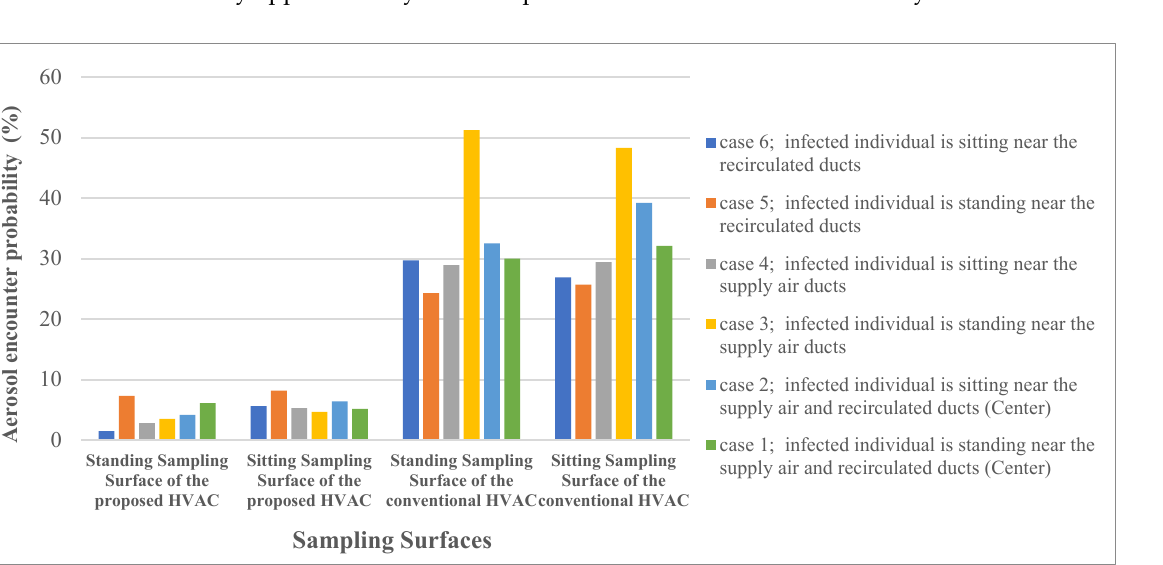
Figure 15. Comparison of aerosol encounter probability for cases 1 to 6.